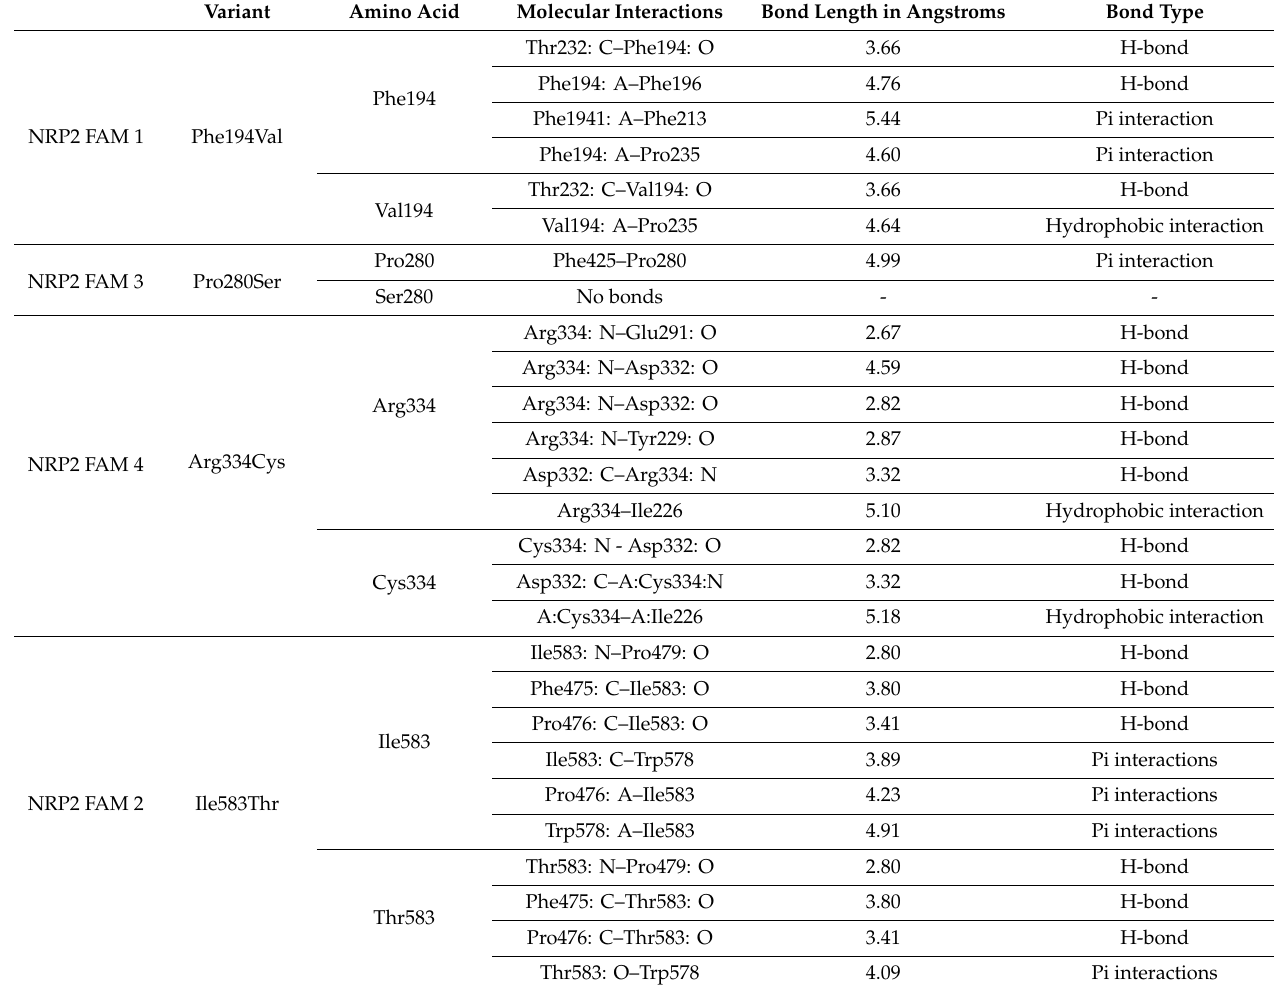
Table 6. Details of molecular interactions with adjacent residues of the wildtype or variant residue in the modeled NRP2 protein in family 1 (Phe194Val), family 3 (Pro280Ser), family 4 (Arg334Cys) and family 2